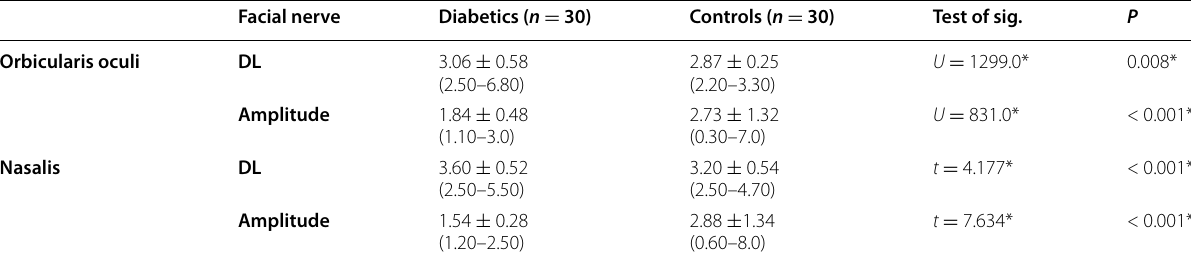
Data are presented as mean SD (minimum-maximum). t , Student t -test; U , Mann-Whitney test; n , number; DL , distal motor latency; P , P -value for comparing ± between the studied groups. *Statistically significant at P